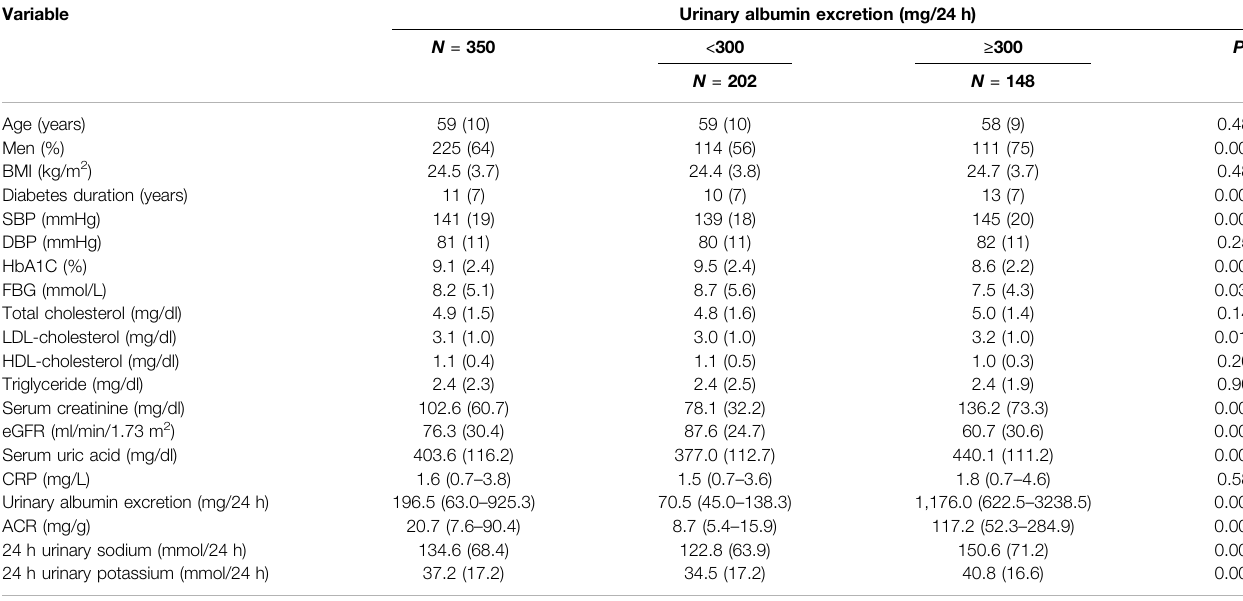
TABLE 1 | Characteristics of 350 patients with DKD according to 24 h urinary albumin excretion.